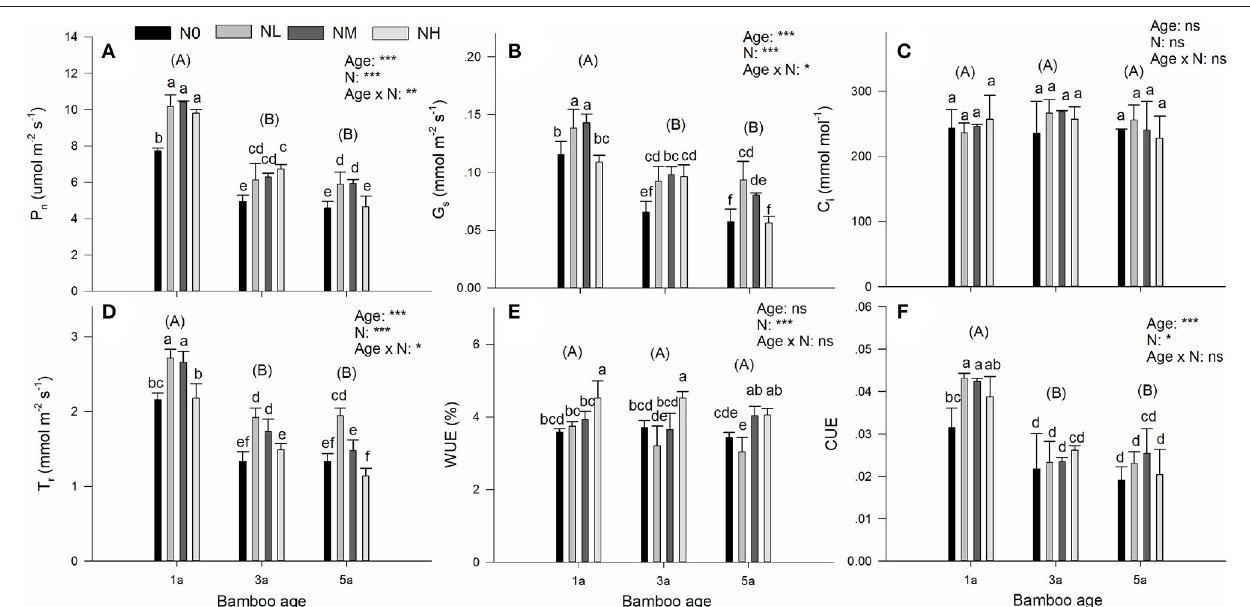
FIGURE 1 | Effects of nitrogen deposition and tree age on gas exchange parameters in Moso bamboo leaves in a factorial experiment. One-year-old (1a), 3-year-old (3a), and 5-year-old (5a) trees were included in the experiment. Nitrogen deposition treatments: Ambient deposition with no addition (N0, control), low addition (NL =